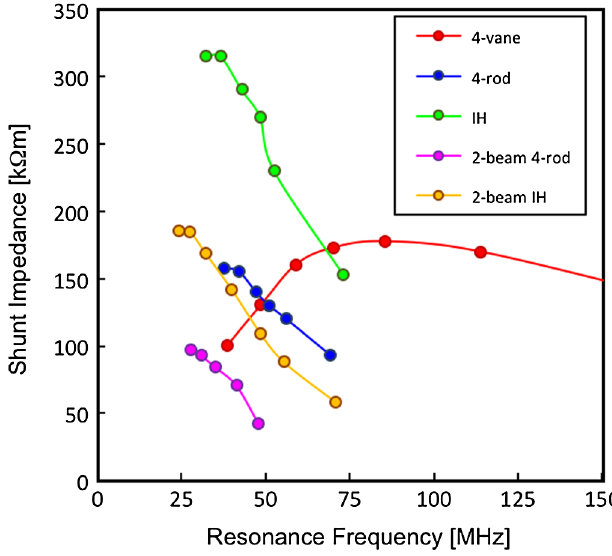
FIG. 19. Shunt impedance as a function of resonance fre- quency in the RFQ linacs. The shunt impedance is estimated as the Kilpatrick factor 1.8 and 60% calculated Q